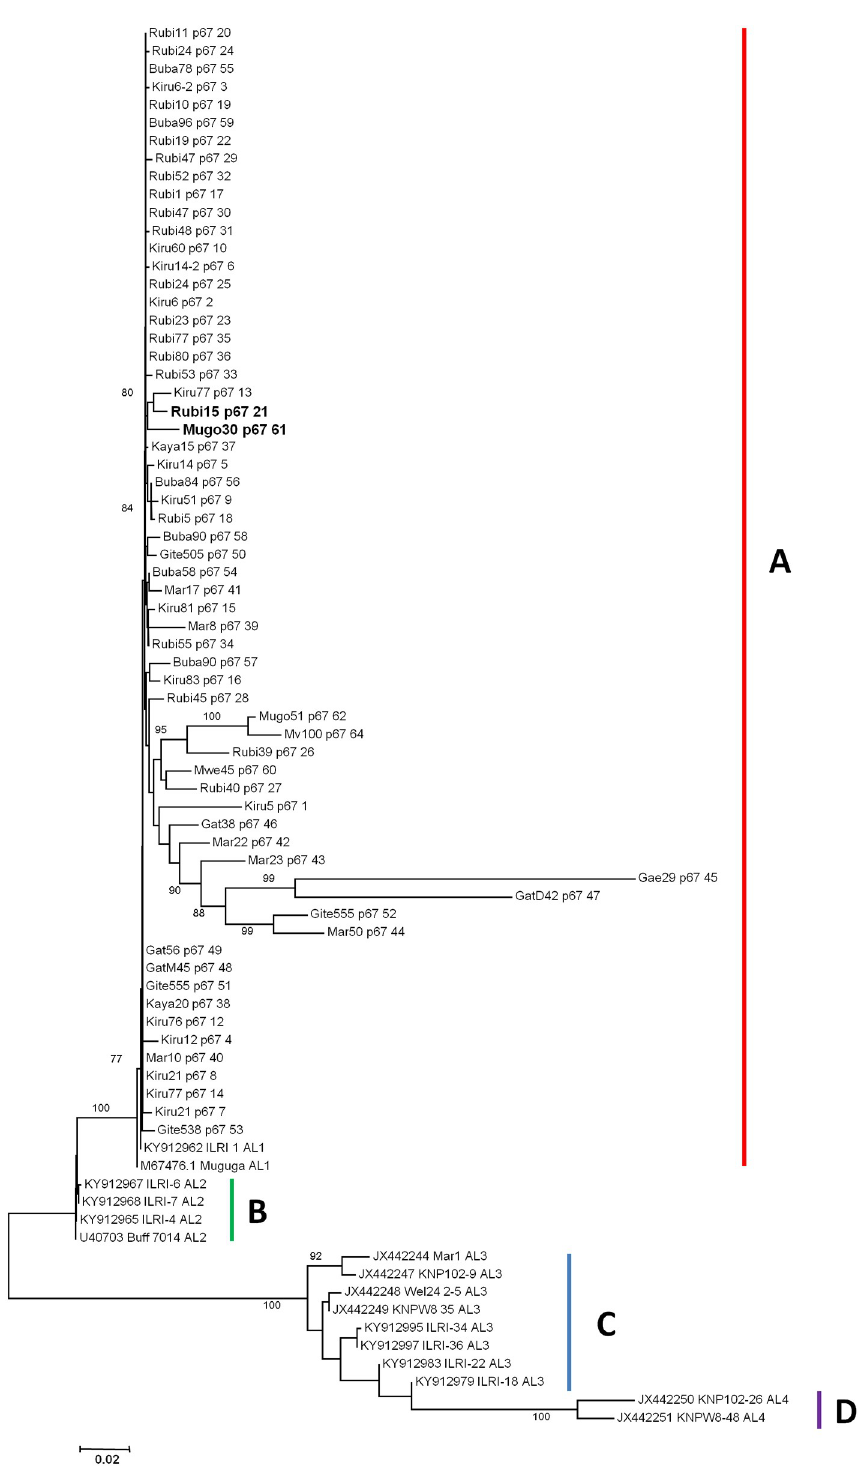
Fig 2. p67 neighbour joining phylogenetic tree based on 821 bp nucleotide sequences from Burundi as well as reference sequences from east and Southern Africa. The phylogenetic tree was constructed using MEGA ver. 6 with 1000 bootstrap replicates as a level of